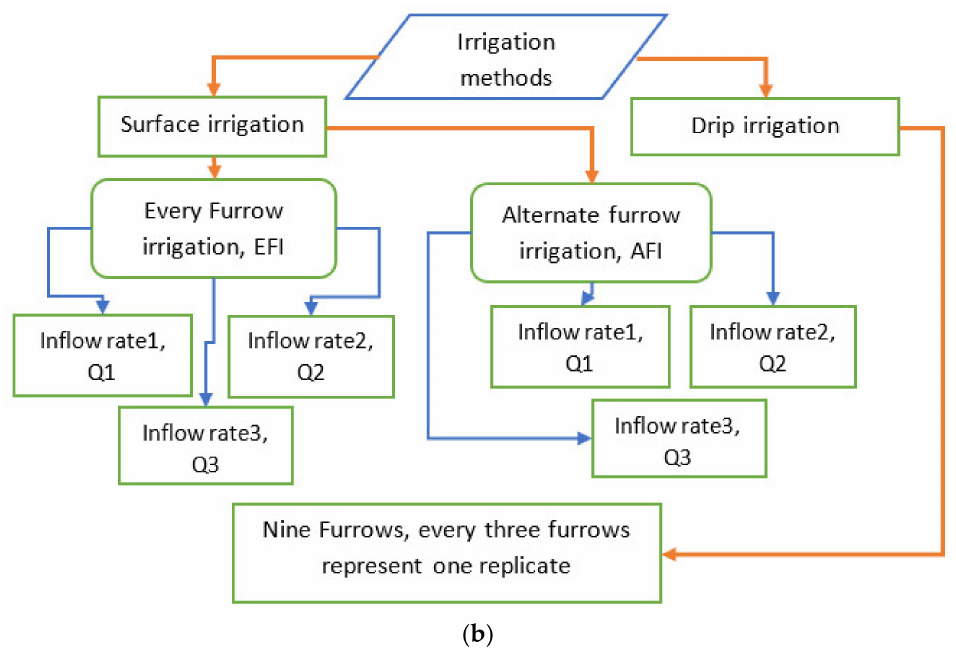
Figure 1. ( a ) The experimental set-up; ( b ) flowchart of the experimental